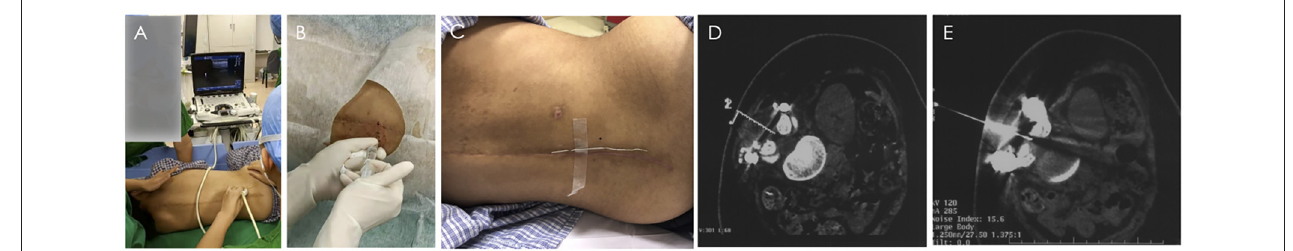
FIGURE 2 | Nusinersen intrathecal injection process under the guidance of B-ultrasound and CT. (A,B) Real-time ultrasound-guided lumbar puncture. (A) Ultrasound probe position of paramedian sagittal oblique scan at the level of lamina. (B) Local anesthesia before intrathecal injection. C-E CT-guided lumbar puncture. (C) Place a metal positioning wire at the posterior midline around the lumbar spine. (D) Determine the needle insertion route through CT scan, and calculate the needle insertion point on the body surface and needle insertion angle. (E) The puncture needle successfully entered the subarachnoid space).